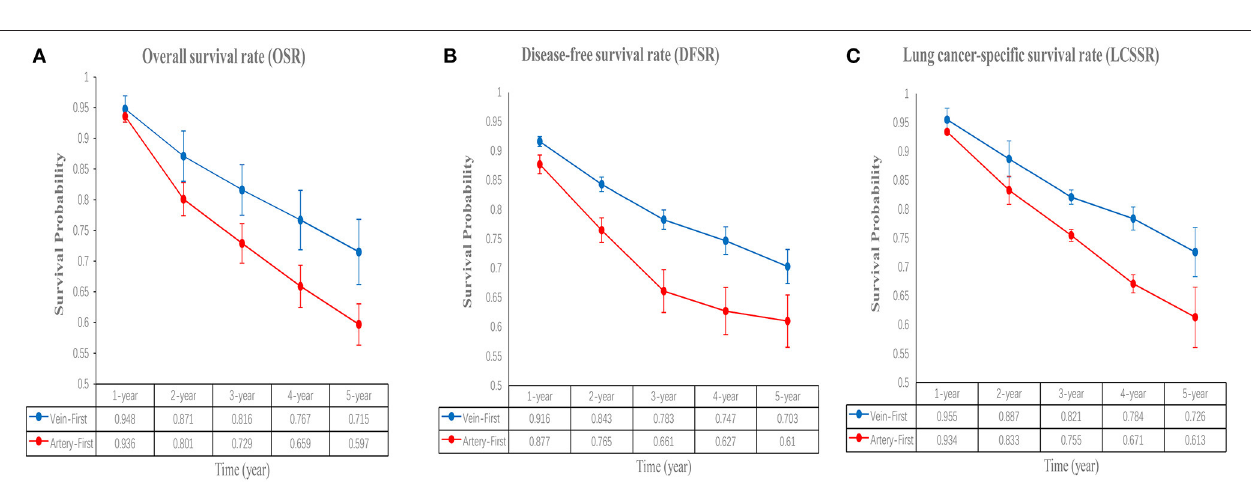
FIGURE 3 | Comparisons of OSR (1–5 years, A ), DFSR (1–5 years, B ), and LCSSR (1–5 years, C ) associated with Vein-first vs. Artery-first according to survival time.